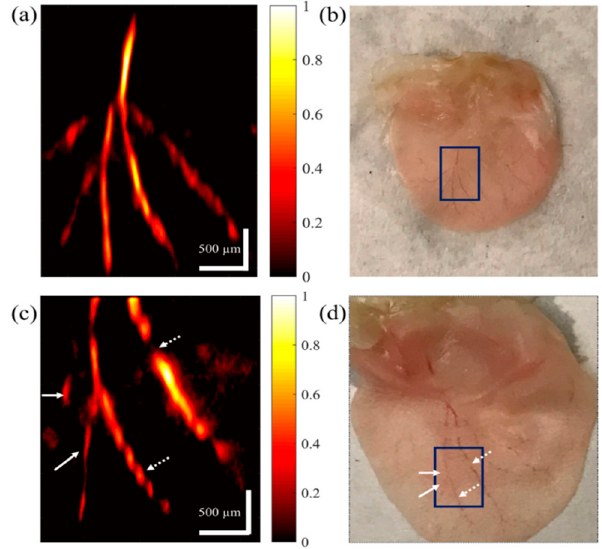
Figure 4. ( a , c ) PAM image of the vasculature on a mouse ear ex vivo. The color bars represent normalized PA amplitude. ( b , d ) Photograph of the mouse ear in ( a , c ), respectively. Reproduced with permission from Ref. [34].